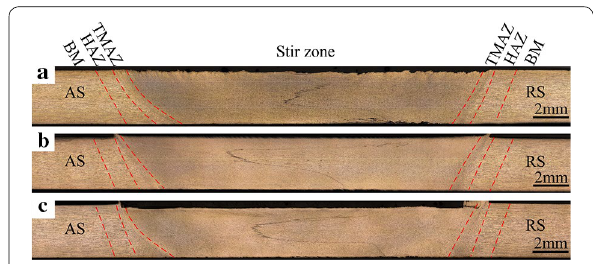
Figure 5 Weld transverse cross-section with respect to the tool rotating speed: a 200 r/min; b 300 r/min; c 400 r/min